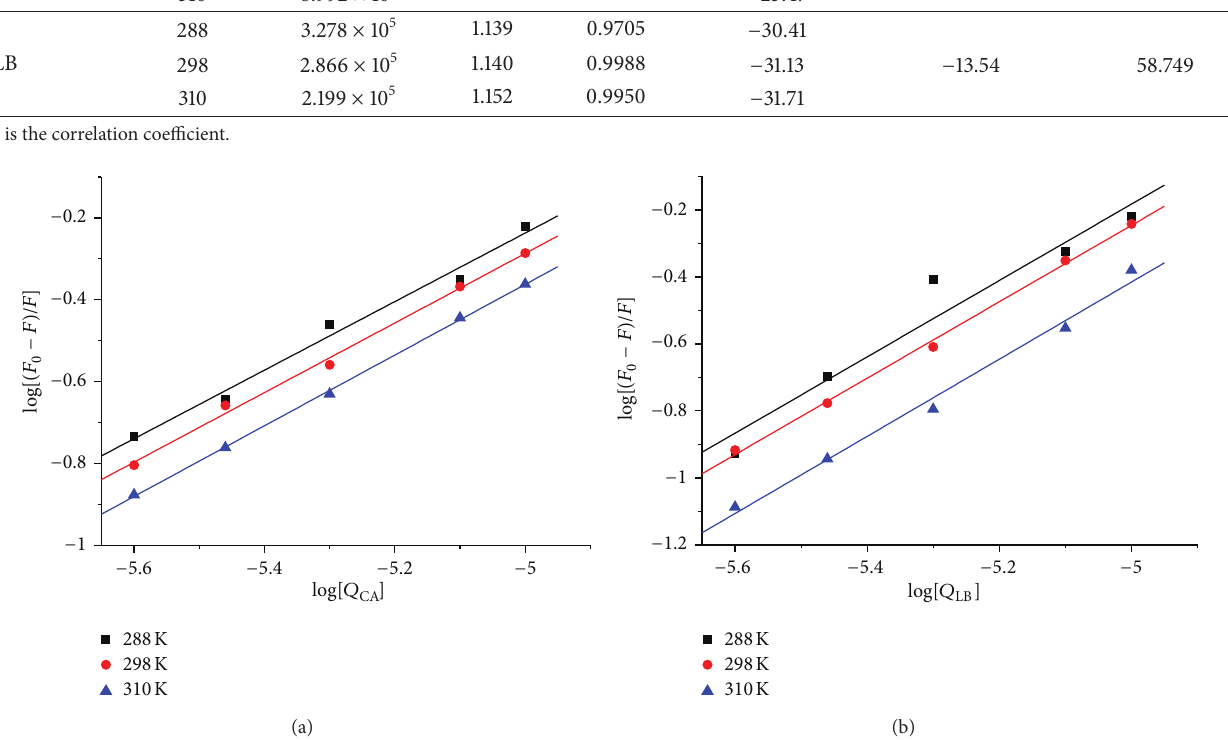
] and log [𝑄 ] at different CA LB